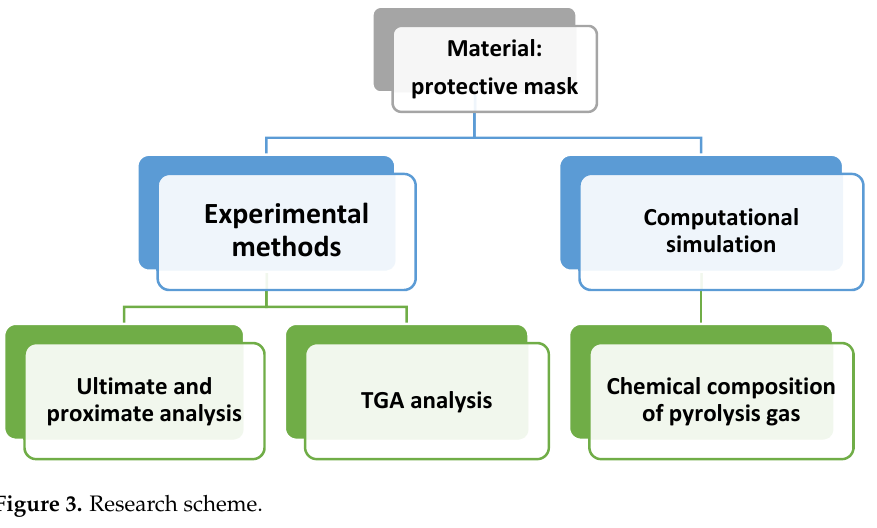
Figure 3. Research scheme.